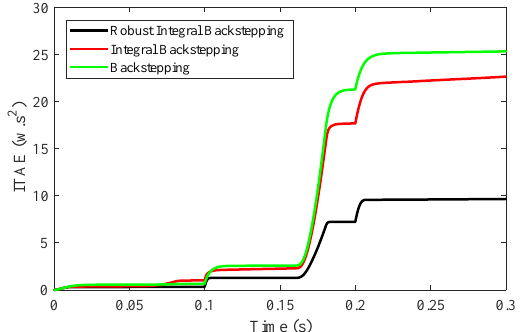
Figure 16. ITAE for multiple faults under varying irradiance and